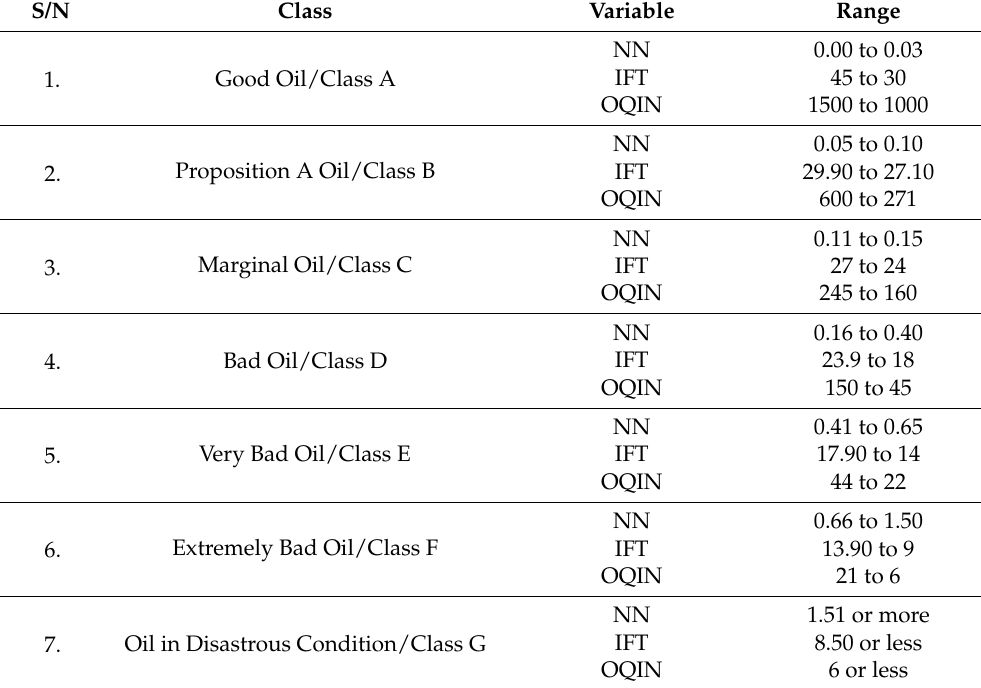
Table 4. Modified Oil Quality Index